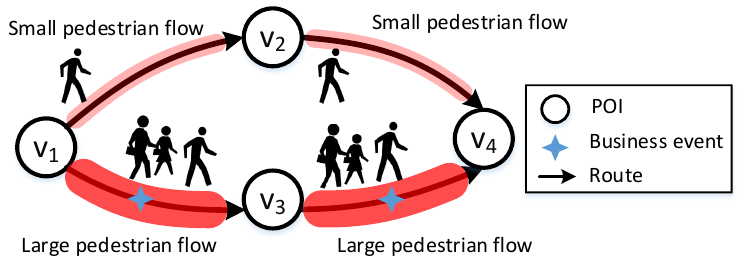
Figure 1. Business event increases the pedestrian flow of a